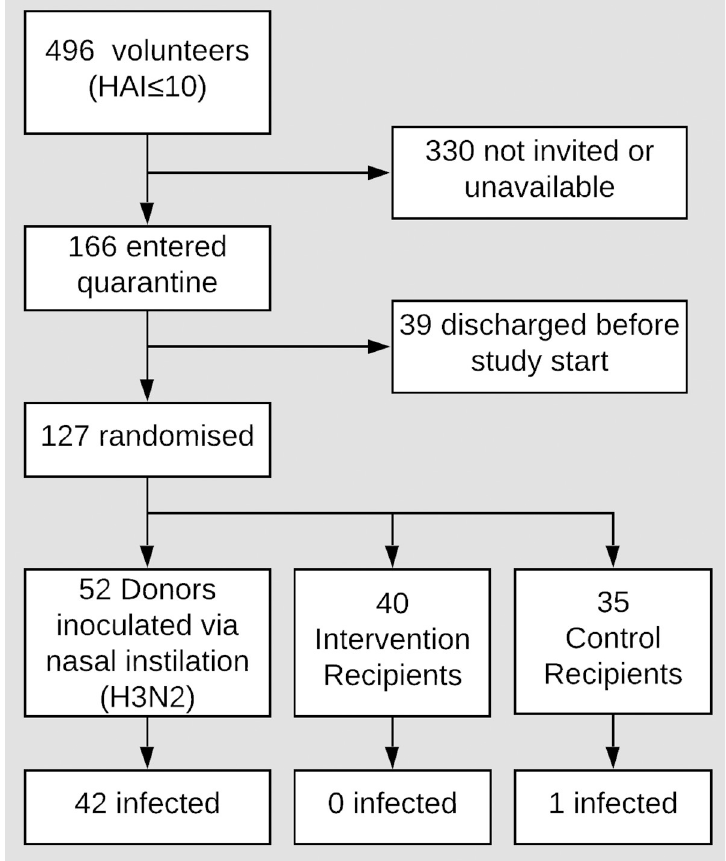
Fig 2. Trial profile. Intervention Recipients: wore face shields, used hand sanitizer every 15 min and only allowed to touch face with single-use wooden spatula; Control Recipients: did not use face shields or the specified hand hygiene